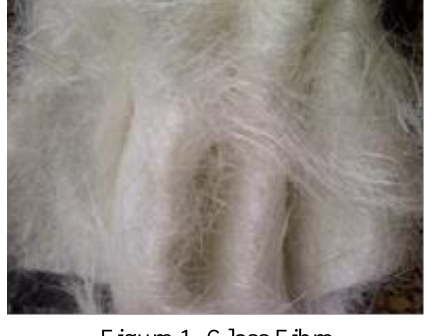
Figure 1. Glass Fibre Figure 2. Sisal